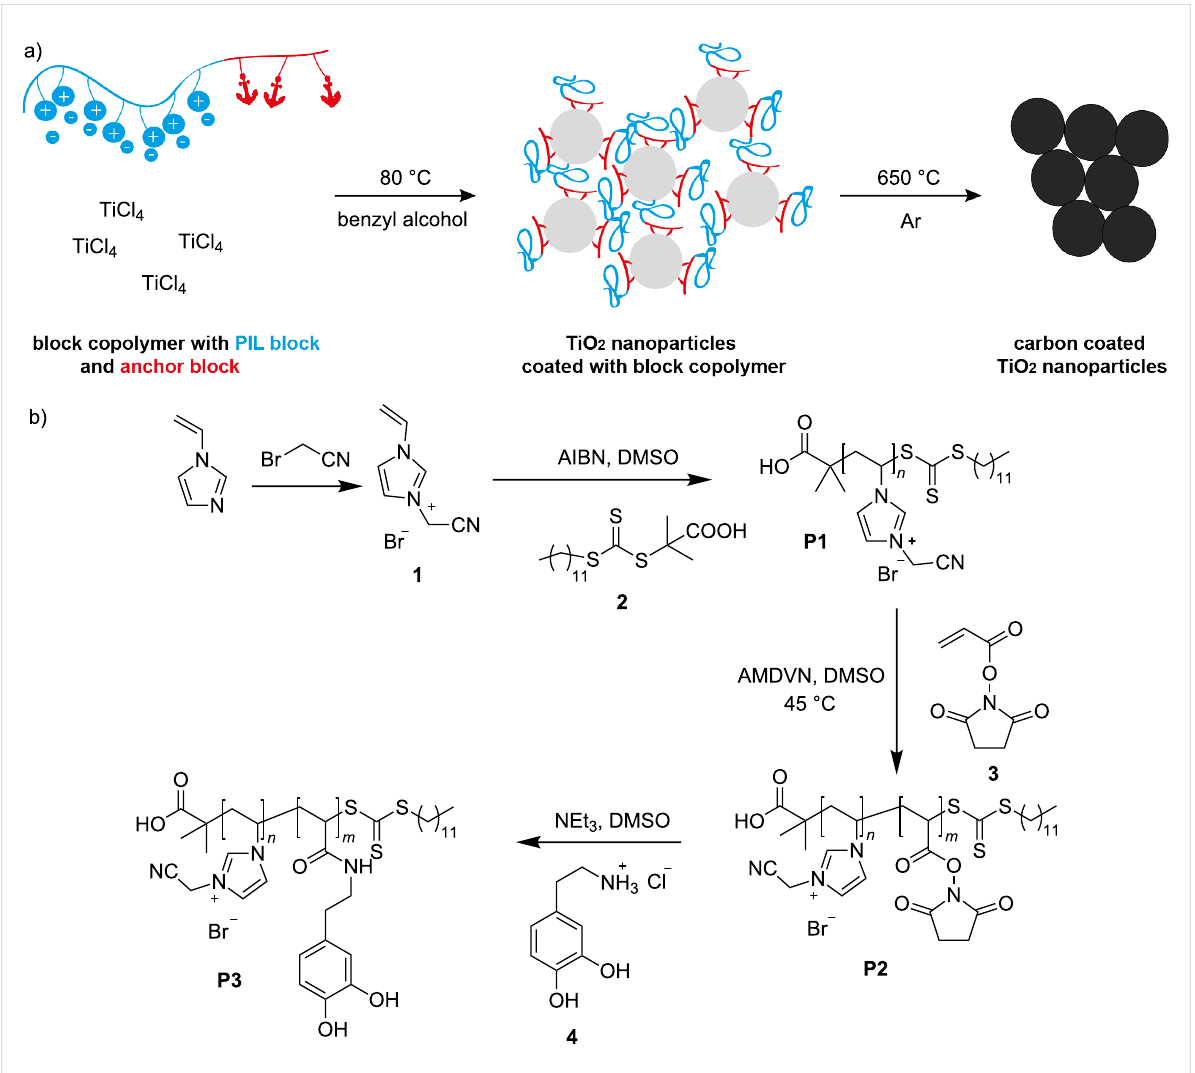
Figure 1: (a) Schematic illustration of the synthesis route of carbon coated TiO 2 nanoparticles. (Left) in situ synthesis of the TiO 2 nanoparticles with the block copolymer as a ligand on the surface followed by the pyrolysis of the particles resulting in homogenously coated nanoparticles. (b) Synthesis route for the preparation of the block copolymer, beginning from the monomer synthesis to the block copolymer and finally the post-polymerization modification step.